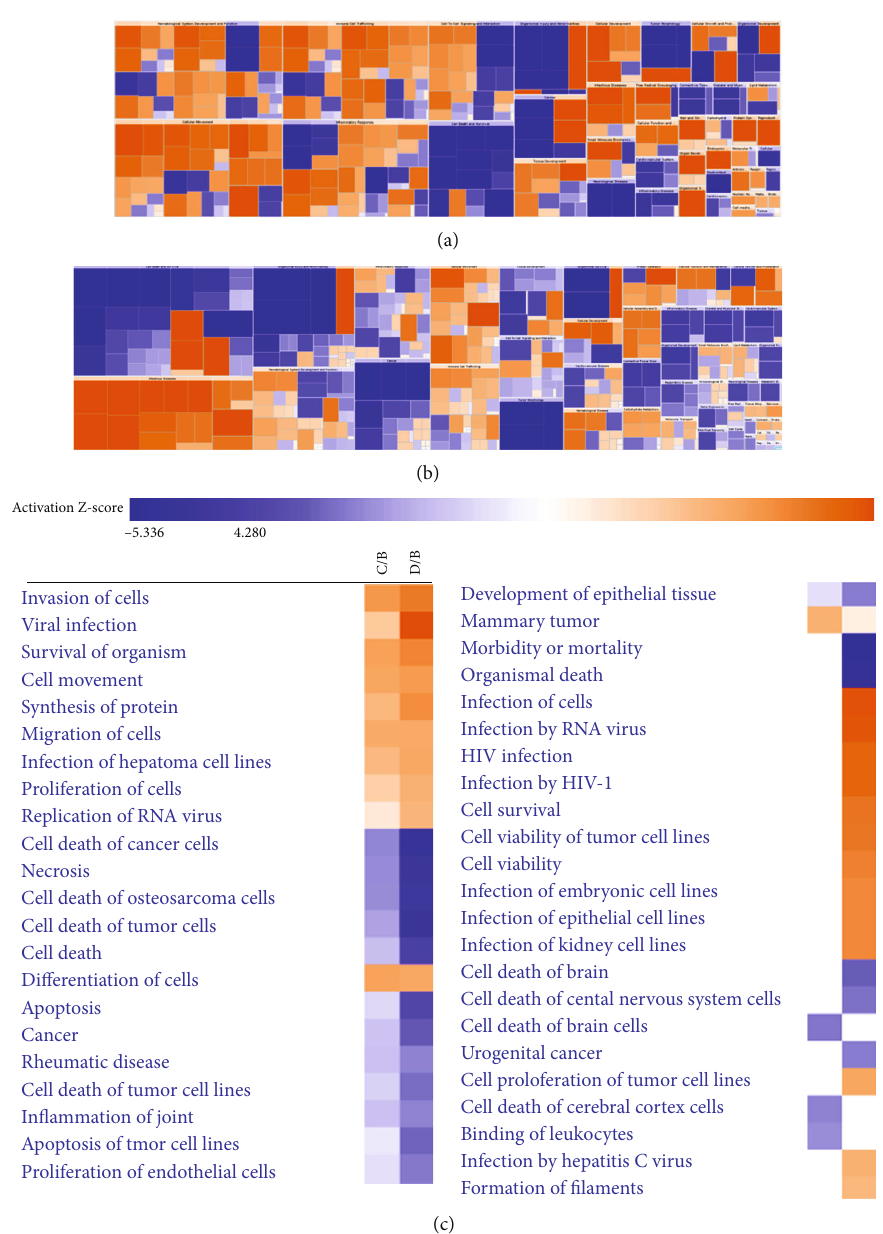
Figure 5: Heatmap of clustering analysis of di ff erential proteins in exudates at di ff erent stages. (a) The clustering analysis of di ff erential protein e ff ect in C group (middle exudate) compared with that in B group (early exudate). (b) The clustering analysis of di ff erential protein e ff ect in D group (late exudate) compared with that in B group (early exudate). (c) Analysis of trends in e ff ects of di ff erential proteins in CD/B